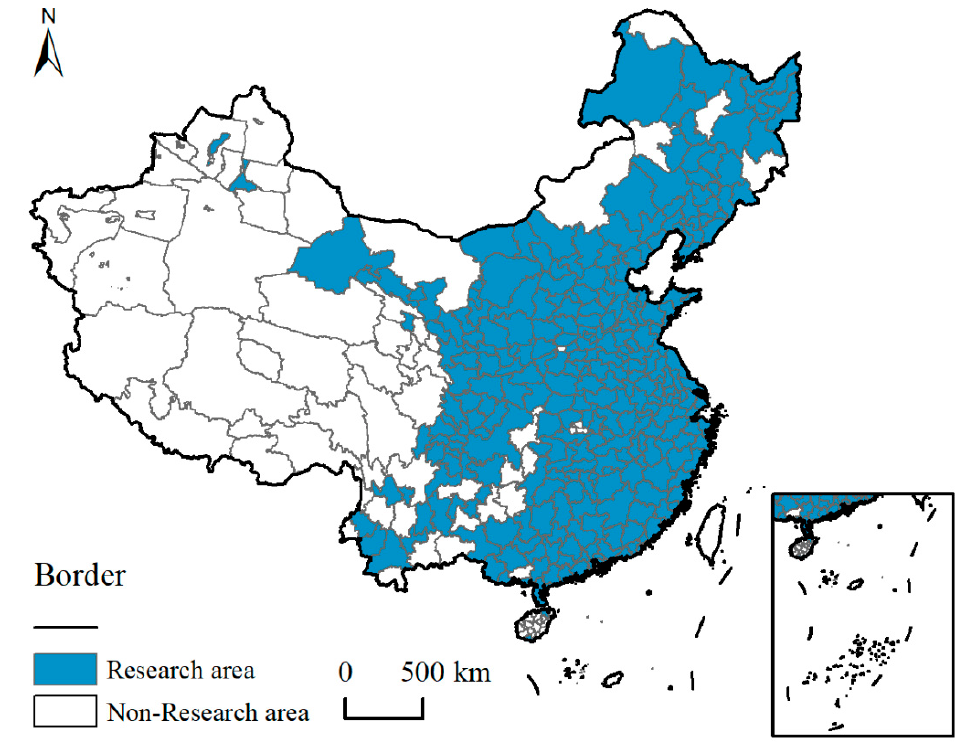
Figure 1. Research area.